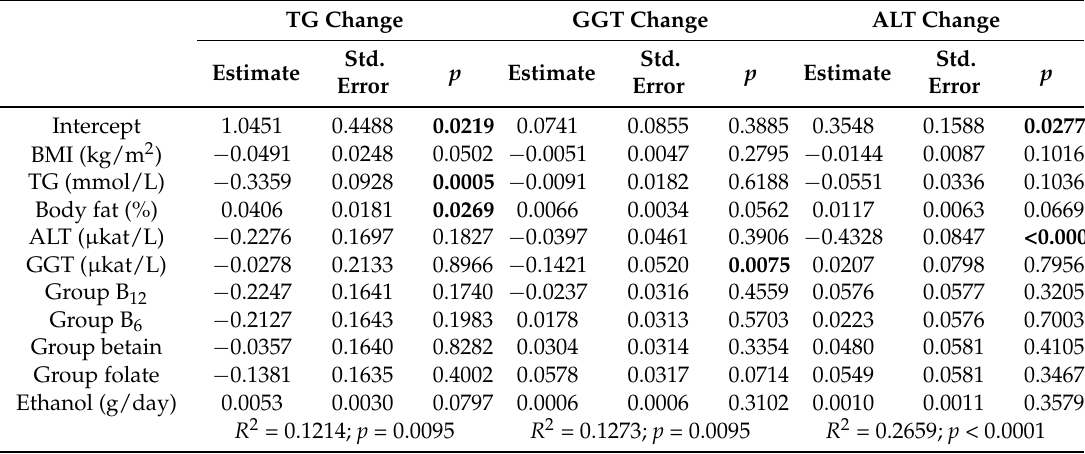
Table 7. Factors influencing changes of TG, GGT and ALT. Ethanol, pre-study ethanol consumption in grams per day. TG Change GGT